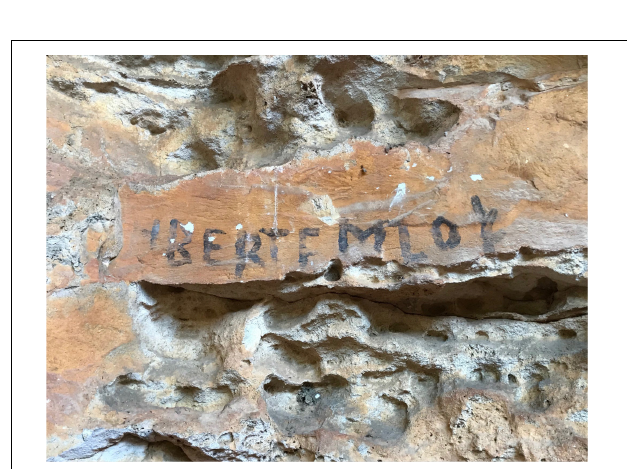
FIGURE 8 | Graffiti on the eastern end of the northern wall of the Anjohimpaty Rock Shelter.